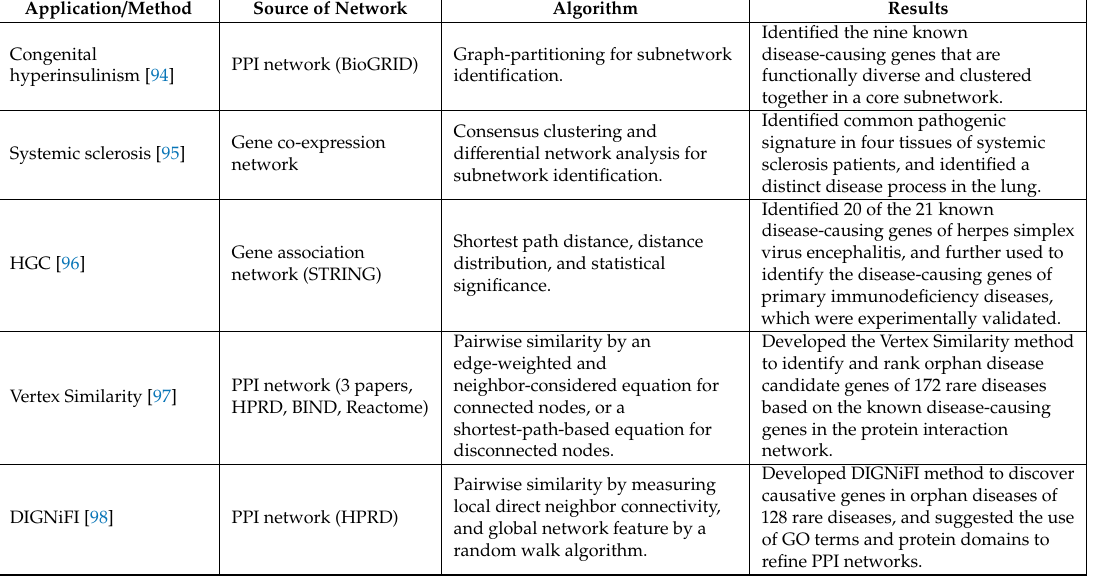
Table 3. The applications and methods of biological networks in studying rare